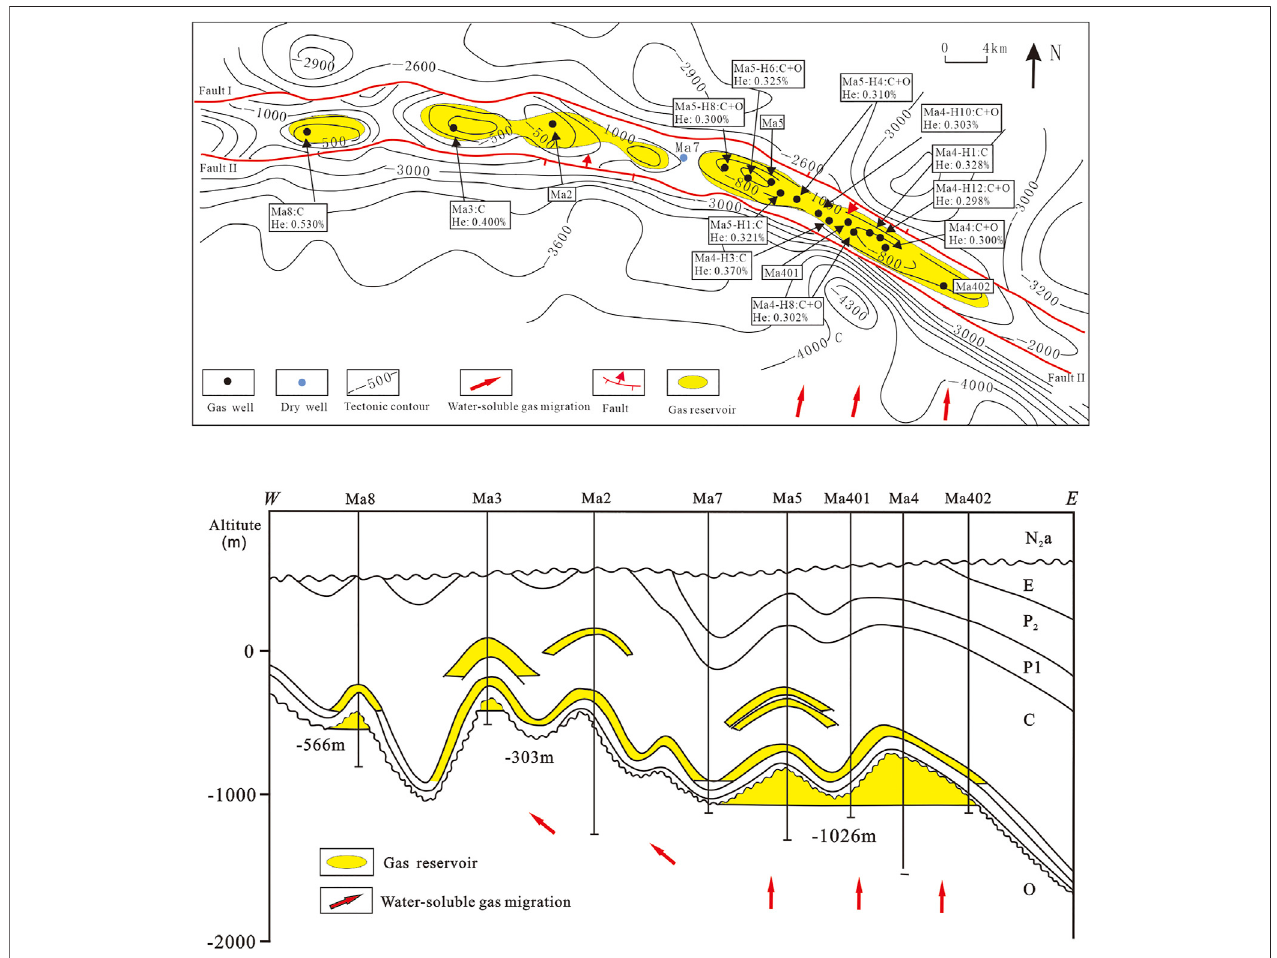
FIGURE 8 | Schematic diagram of water-soluble gas accumulation in Hetianhe Gas Field (The location of Hetianhe gas fi eld is shown in Figure 1 ; The helium data are cited from Tao et al., 2019).